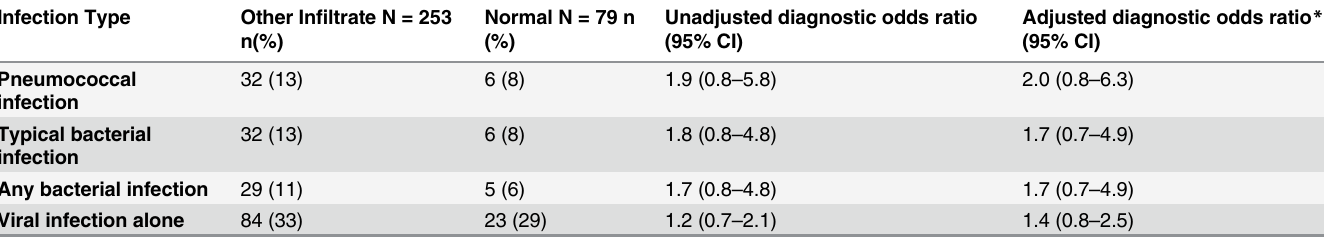
Table 4. Association between other infiltrate and different types of infections. Infection